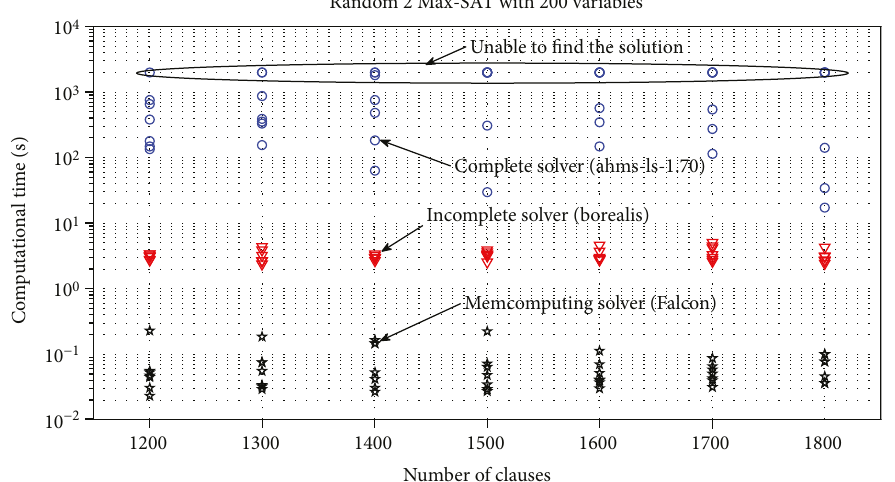
Figure 6: Results from the 2016 Max-SAT competition for the random Max-2SAT problem compared with our memcomputing solver,